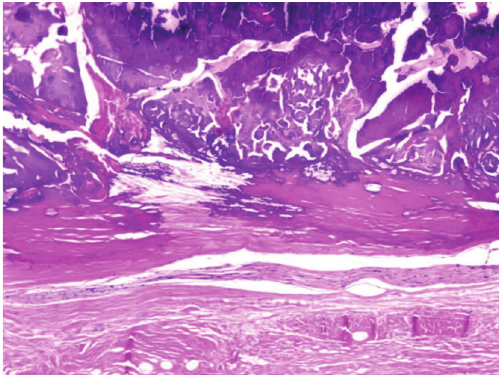
Figure 2: Fibroosseous lesion in dermis. There is a well-shaped, large fibroosseous metaplastic area